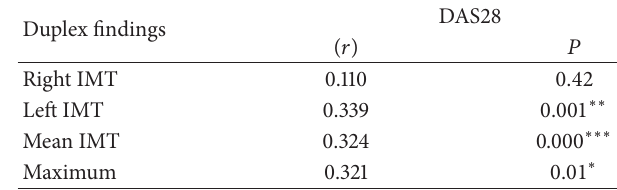
Table 16: Correlation between DAS28 and ultrasonographic duplex findings in RA